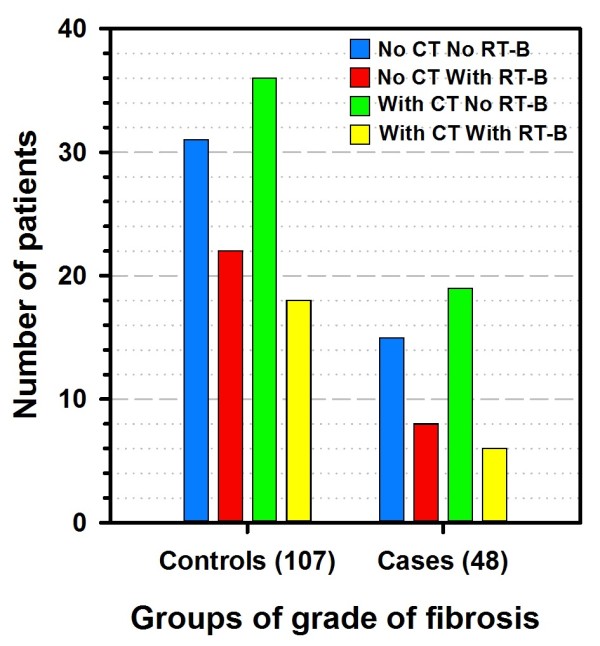
Distribution of the 155 nasopharyngeal carcinoma patients according to the grade of subcutaneous and deep tissue fibrosis following radiotherapy. The patients developed either minimal to moderate (controls: G0-2) or severe (cases: G3-4) fibrotic reactions. Patients who received chemotherapy (CT) or radiotherapy boost (RT-B) are indicated.